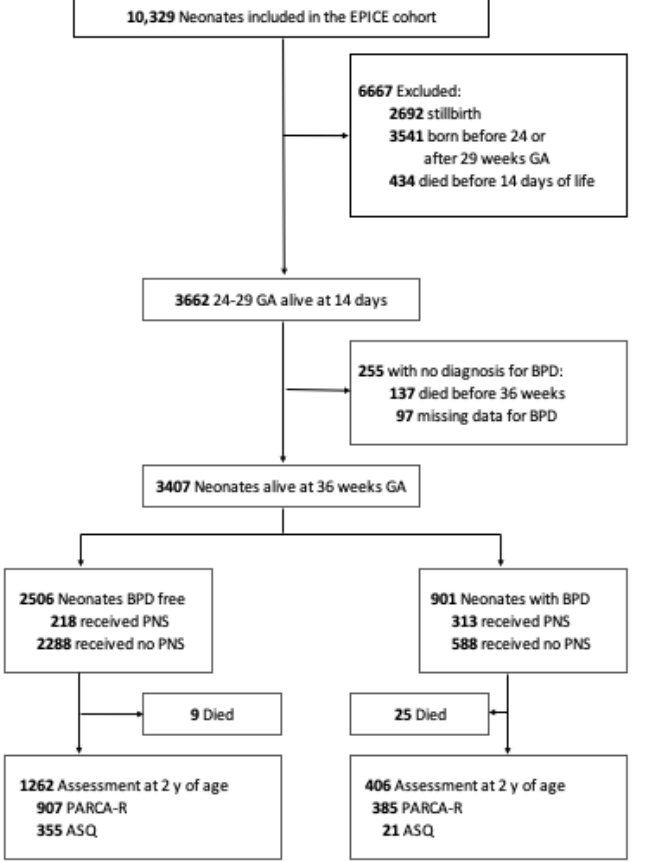
Figure 1. Study Flow Chart. Abbreviations: EPICE, Effective Perinatal Intensive Care in Europe; GA, gestational age; BPD, bronchopulmonary dysplasia; PNS, postnatal steroids; PARCA-R, Parent Report of Children Abilities – Revised; ASQ, Ages and Stages Questionnaire.